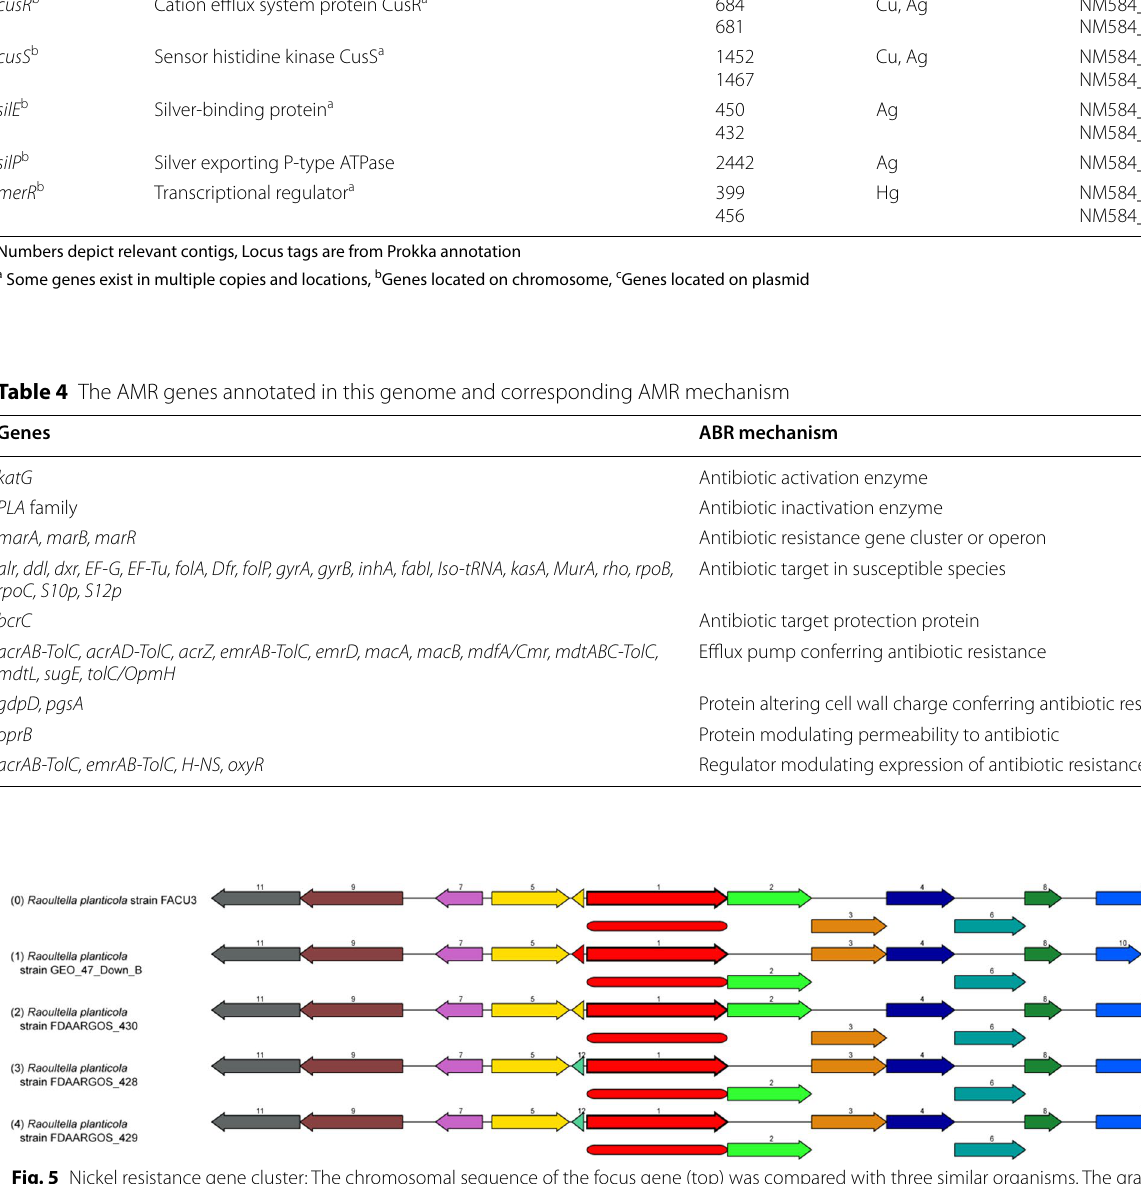
Fig. 5 Nickel resistance gene cluster: The chromosomal sequence of the focus gene (top) was compared with three similar organisms. The graphic depicts the focus gene, which is red and numbered 1. Sets of genes with similar sequence are grouped with the same number and color (1- Nickel ABC transporter, substrate-binding protein NikA, 2- Nickel ABC transporter, permease protein NikB, 3- Nickel ABC transporter, permease protein NikC, 4- Nickel ABC transporter, ATP-binding protein NikD, 5- Transcriptional regulator, LysR family, 6- Nickel ABC transporter, ATP-binding